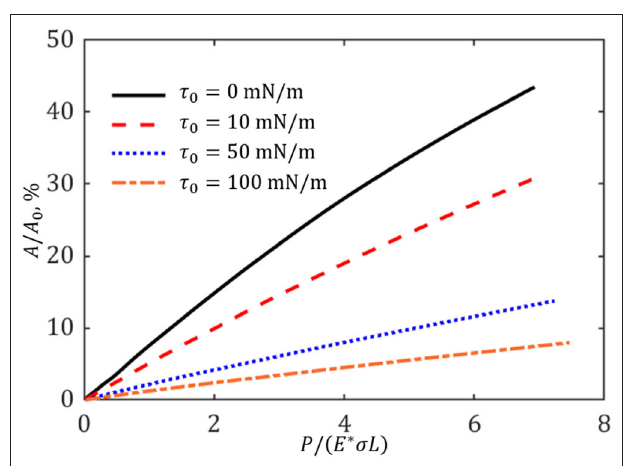
FIGURE 9 | Variations of real contact area with respect to the resultant load for the cases of different membrane/surface